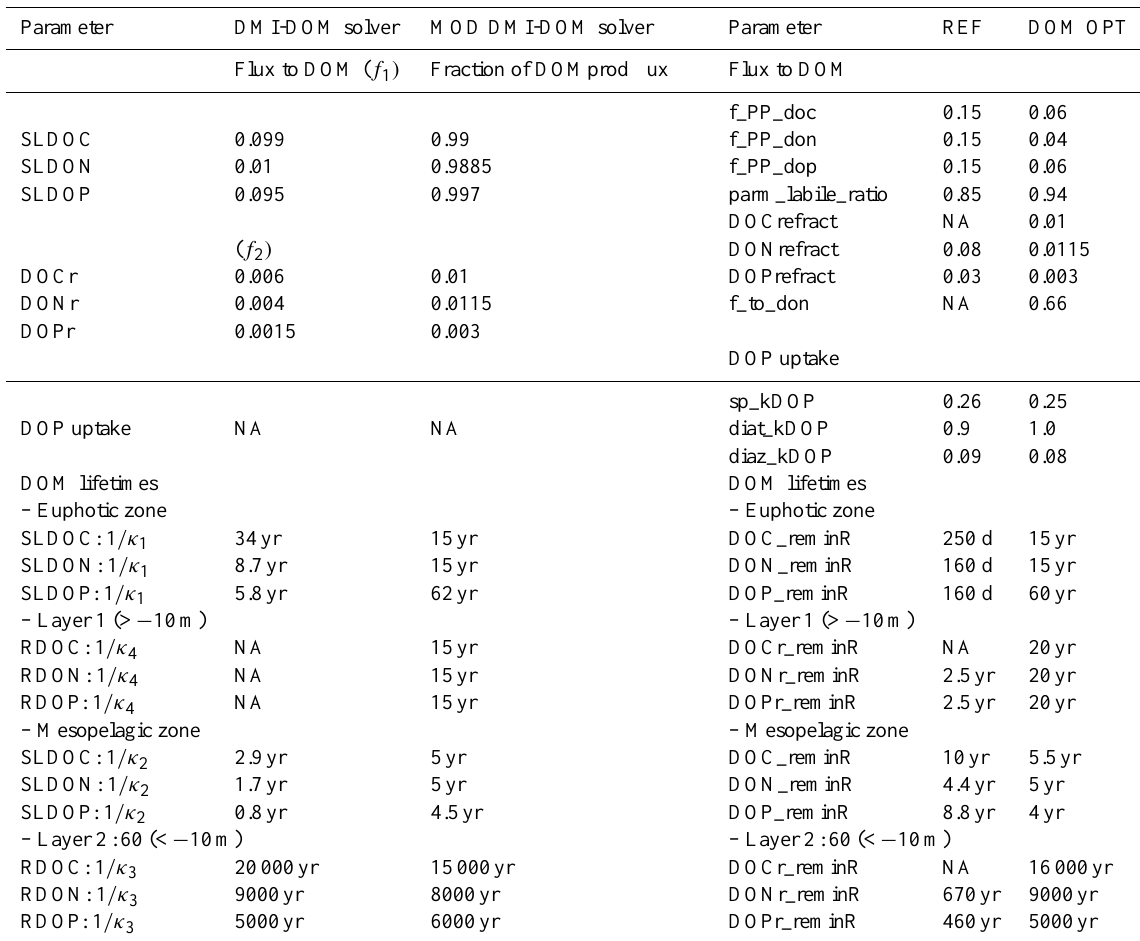
Table 1. Optimized DOM parameters from the DMI-enabled linear DOM model (DMI-DOM solver) and the modified DMI model (MOD DMI-DOM solver) as well as the REF and DOM OPT simulations of the CESM BEC. Euphotic zone: 0–100m for the DMI-DOM mod- els and depths where PAR>1% for REF and DOM OPT. The “flux to DOM” represents the fraction of PP that accumulates as DOM while the “fraction of DOM flux” represents the portion of the DOM production flux that accumulates as semilabile (SL) or refractory